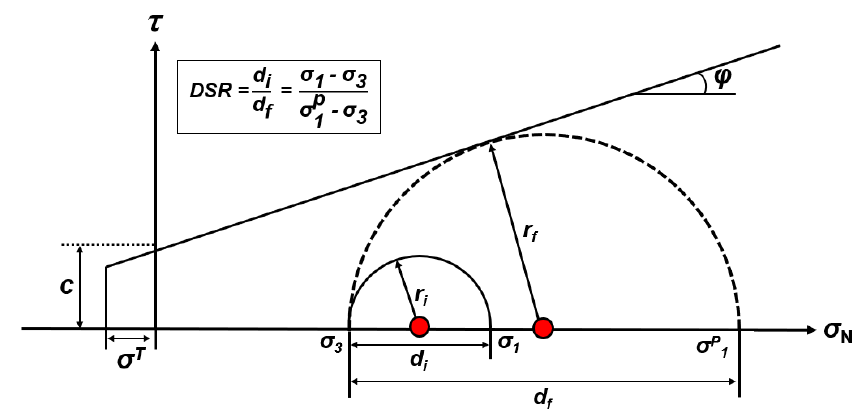
Figure 4. Schematic of variables used within the DSR equation for confined conditions using the Mohr − Coulomb criterion, modified from [79].